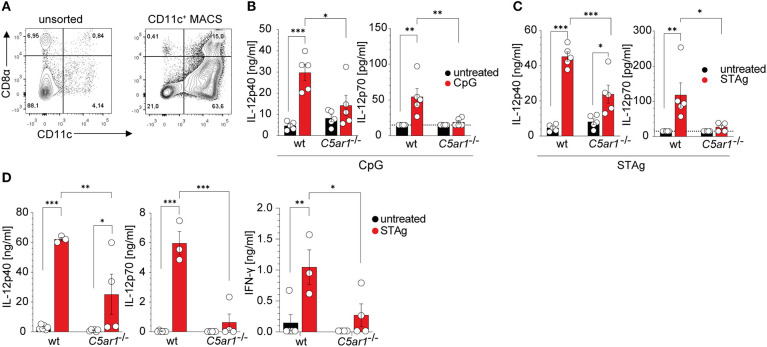
The C5a/C5aR1 axis controls TLR9 and STAg-induced IL-12 production from spleen-residing DCs. (A) Dot plots showing the frequencies of unsorted (left) and CD11c+ MACS positively selected (right) splenic DCs. The numbers in the four quadrants show the frequencies of the individual cell populations. (B) Impact of CpG ODN1668 (1 μg/ml) or (C) STAg (1 μg/ml) stimulation of splenic DCs (1 × 106) from wt or C5ar1−/− mice on IL-12p40 (left) and IL-12p70 (right) production. The dotted line depicts the detection limit of the assay, n = 5/group. (D) Impact of STAg injection (i. p., 100 μg, 6 h) on IL-12p40 (left), IL-12p70 (middle), and IFN-γ (right) serum concentrations in wt and C5ar1−/− mice. The dotted line depicts the detection limit of the assay, n = 3–6/group. Values shown in (B–D) are the mean ± SEM, differences between groups were determined by ANOVA and Sidak's post-hoc test, *p < 0.05, **p < 0.01, ***p < 0.001.